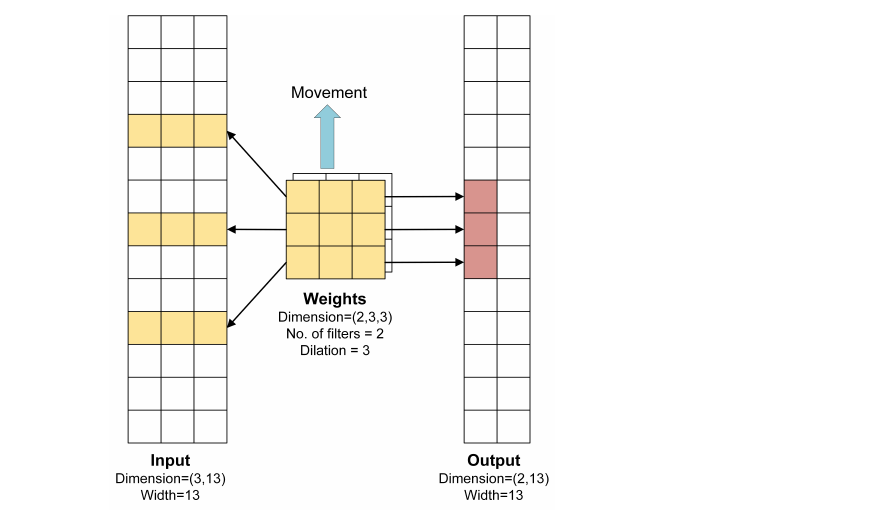
Figure 1. An example of the 1D dilated convolution layer with input channels C = 5, input width W = 13, number of filters K = 2, filter width S = 3, output with Q = 13, and dilation parameter d =